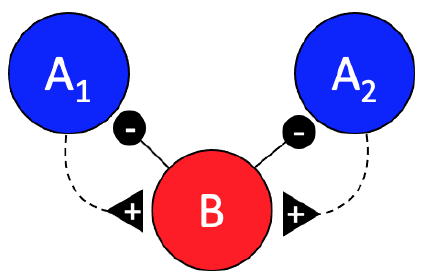
Figure 5. Putative feedback circuit configuration. Increased activity of the A 1 and A 2 cells appears to directly or indirectly induce activity of the B cell, which in turn inhibits the firing of the A